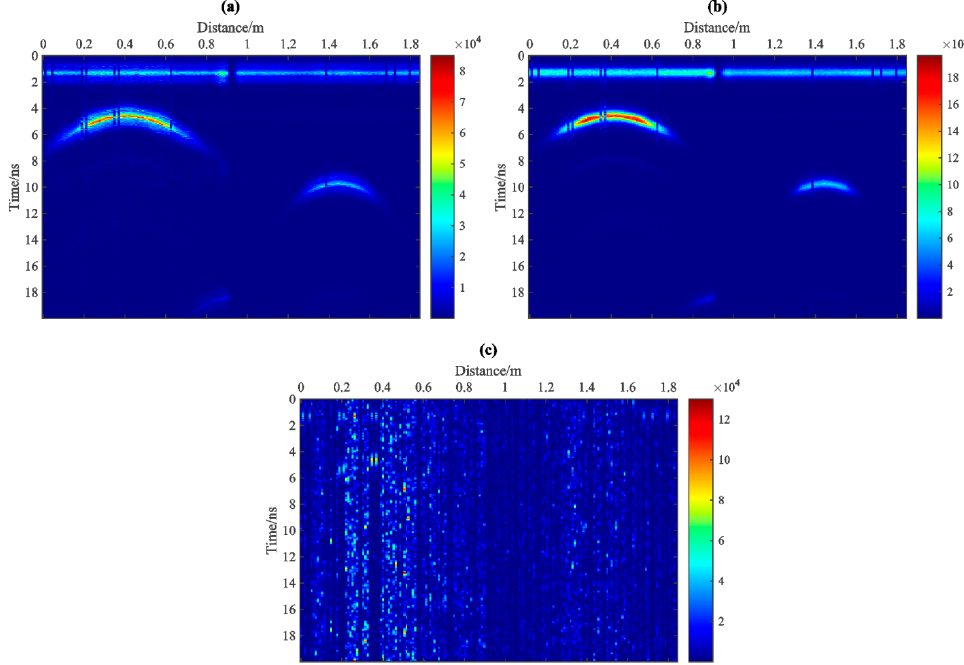
Figure 12. TKEO-slices of the model data using VMD. ( a − c ) show the TKEO-slices 1 − 3,